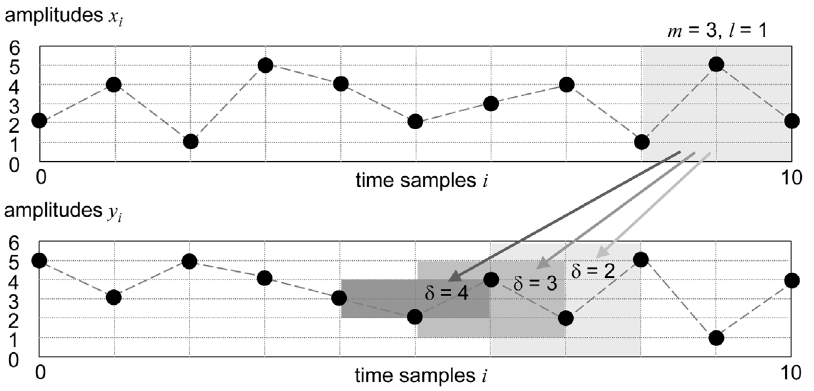
Figure 1. Two exemplary EEG channels x and y showing how T interaction from x to y at different transfer times d =1, 2,